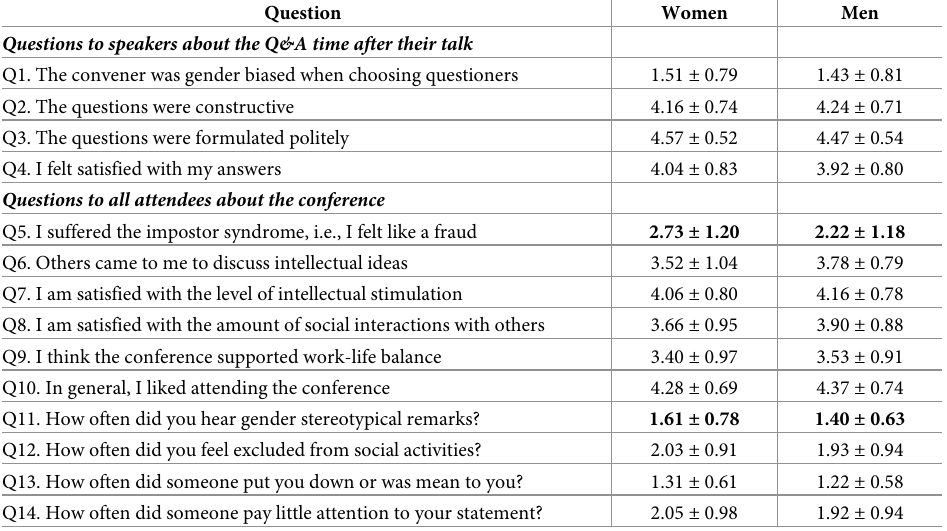
Table 1. Summary of the responses to the five-point Likert scale questions included in the post-conference